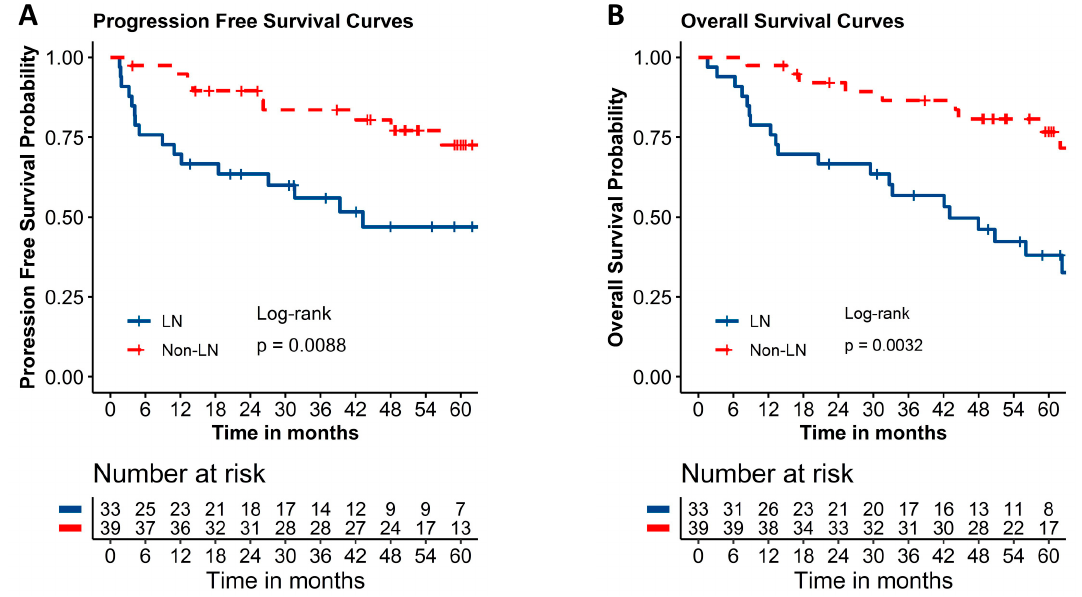
Figure 1. Kaplan–Meier curves depicting comparative 5-year PFS ( A ) and OS ( B ) between LN and non-LN groups of patients with stage IIB cervical cancer. LN: lymph node, OS, overall survival; PFS, progression-free survival.